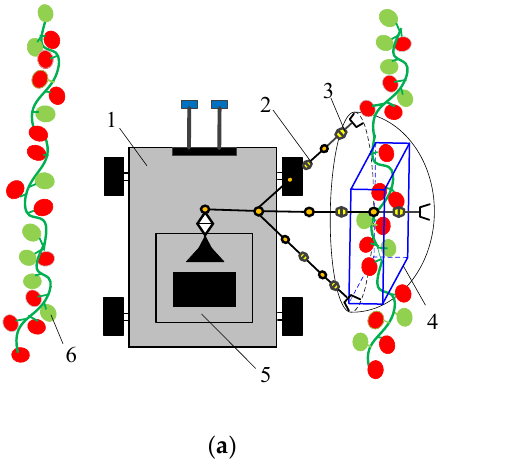
Figure 5. Schematic diagram of the working space of the picking robotic arm. ( a ) Individual picking areas; ( b ) Two adjacent picking areas. 1: wheeled chassis; 2: mechanical arm; 3: end-effector; 4: fan- shaped picking operation space area; 5: lift platform; 6: fruit; 7: walking ridge road; stop point; O : actual stop point. 1